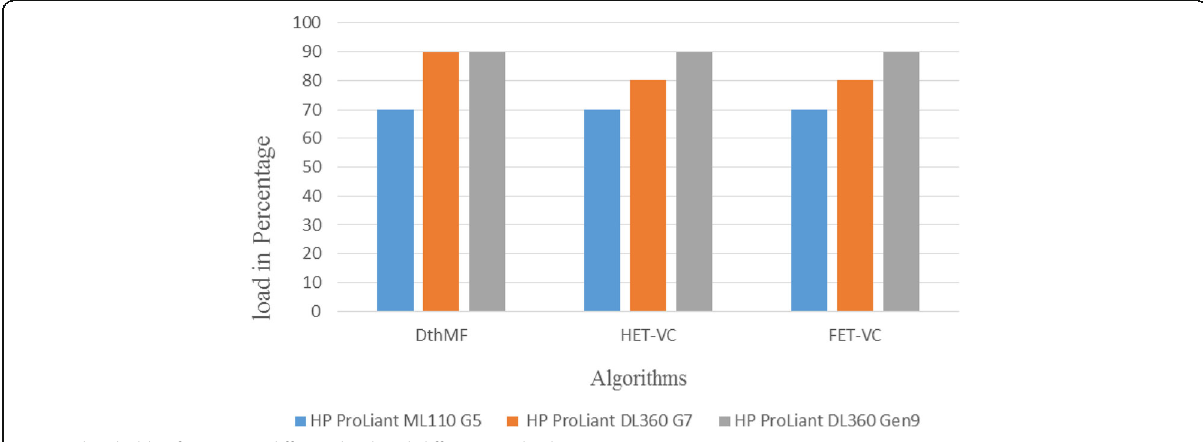
Fig. 5 Thresholds of servers in different load and different